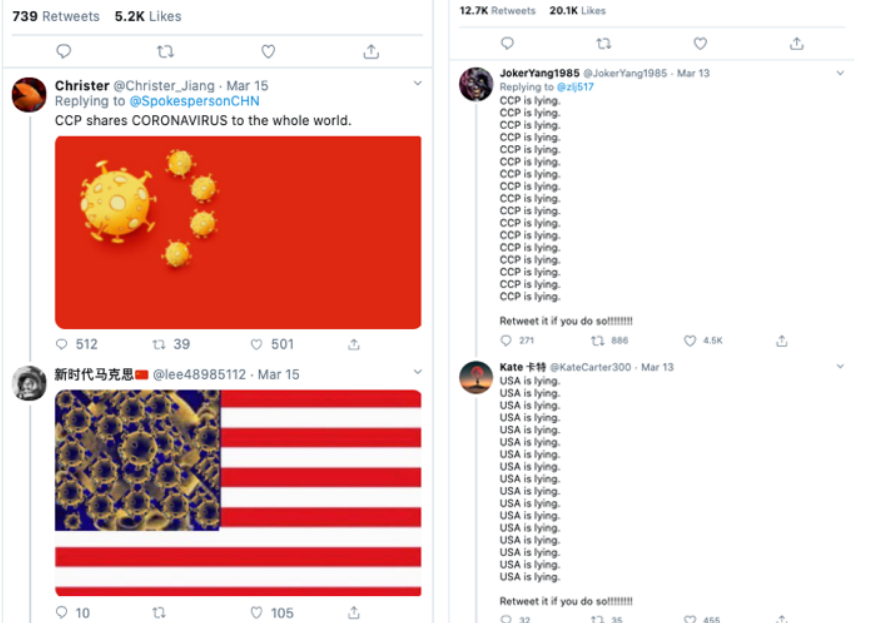
Figure 9. Screenshots of some of the responses to the posts in Figures 2 (left) and 5 (right). Sources: Hua (2020) and L. Zhao